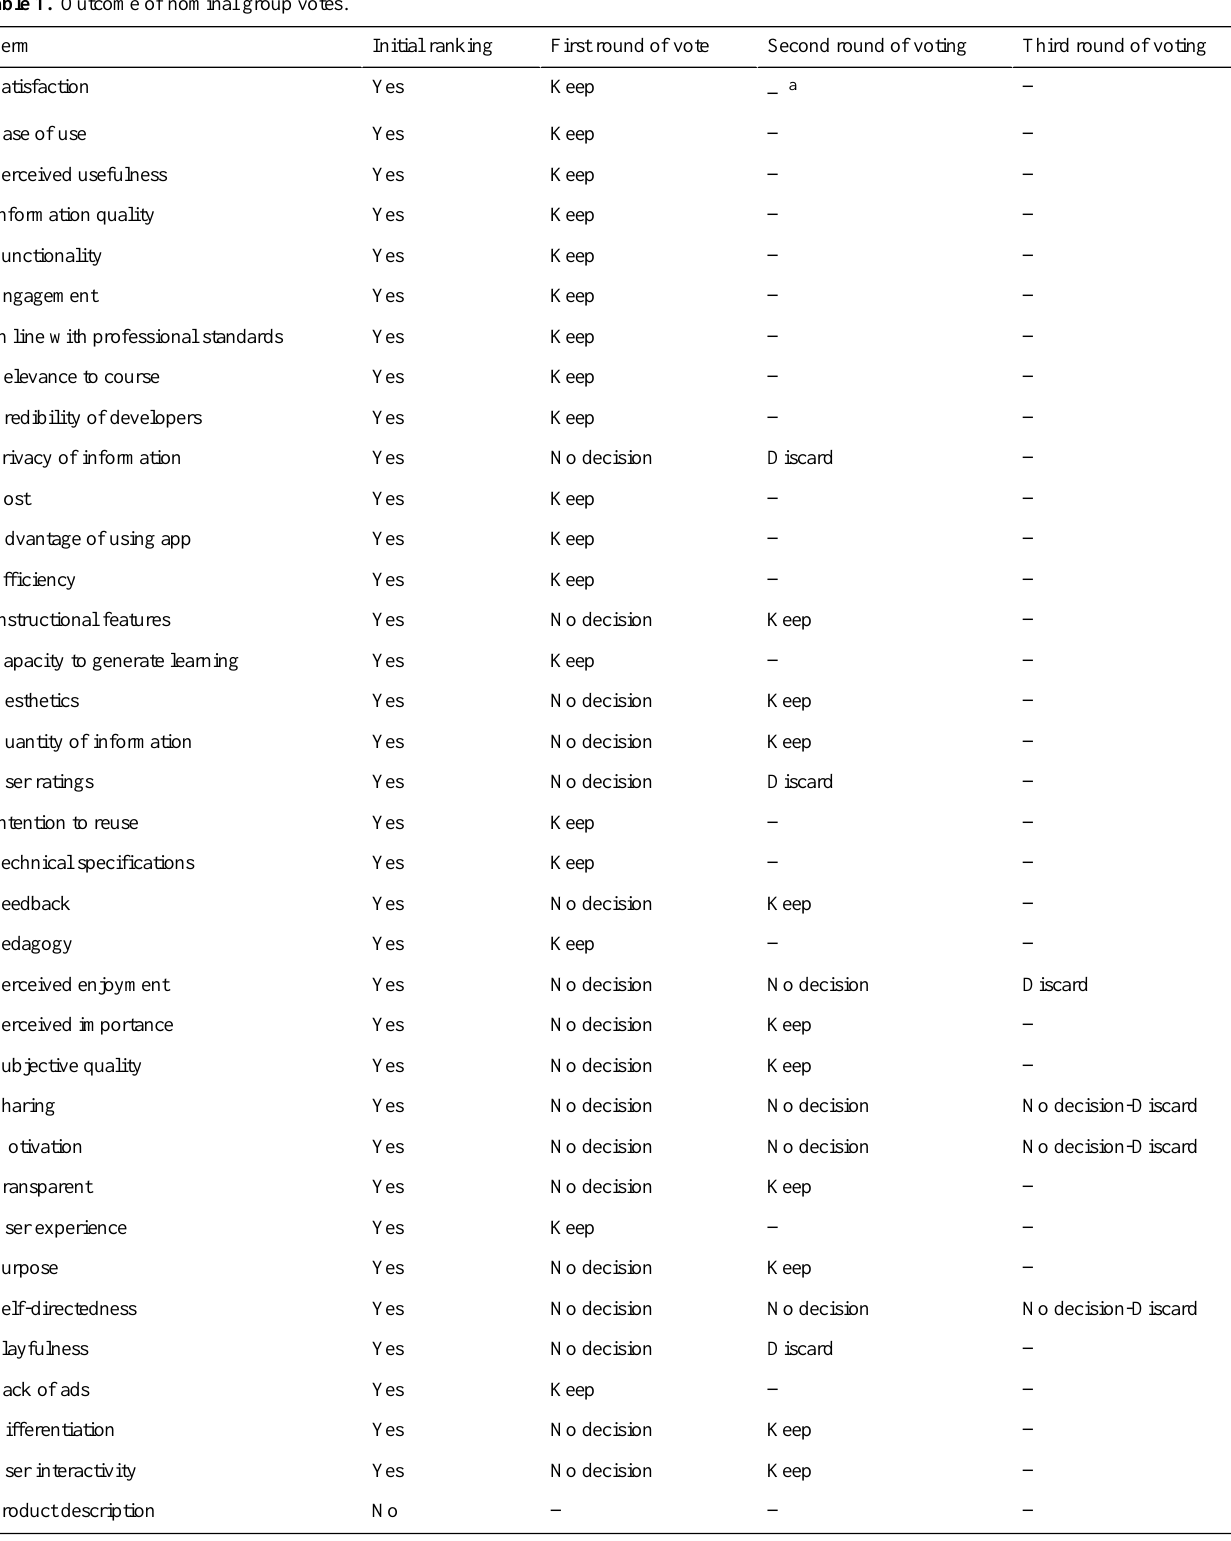
Table 1. Outcome of nominal group